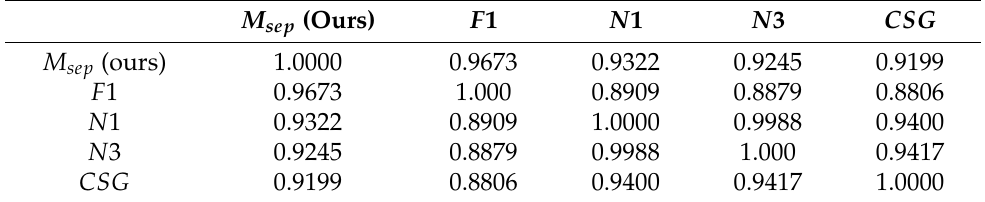
Table 3. The absolute Pearson correlation between M sep and other quality measures.